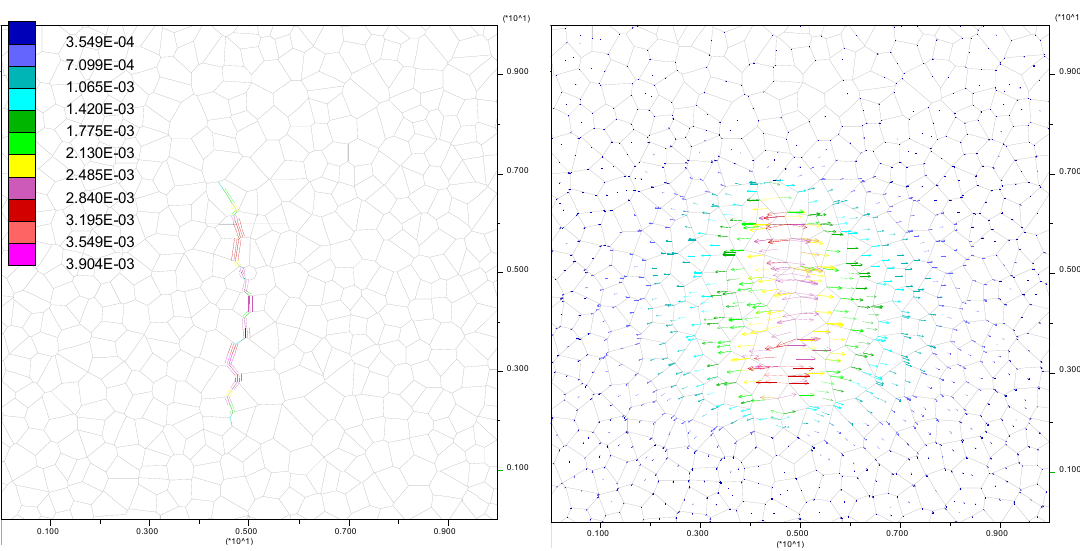
Figure 6. Crossing mode in numerical modeling with an incidence angle of 90 degrees under differential stresses of 15 MPa